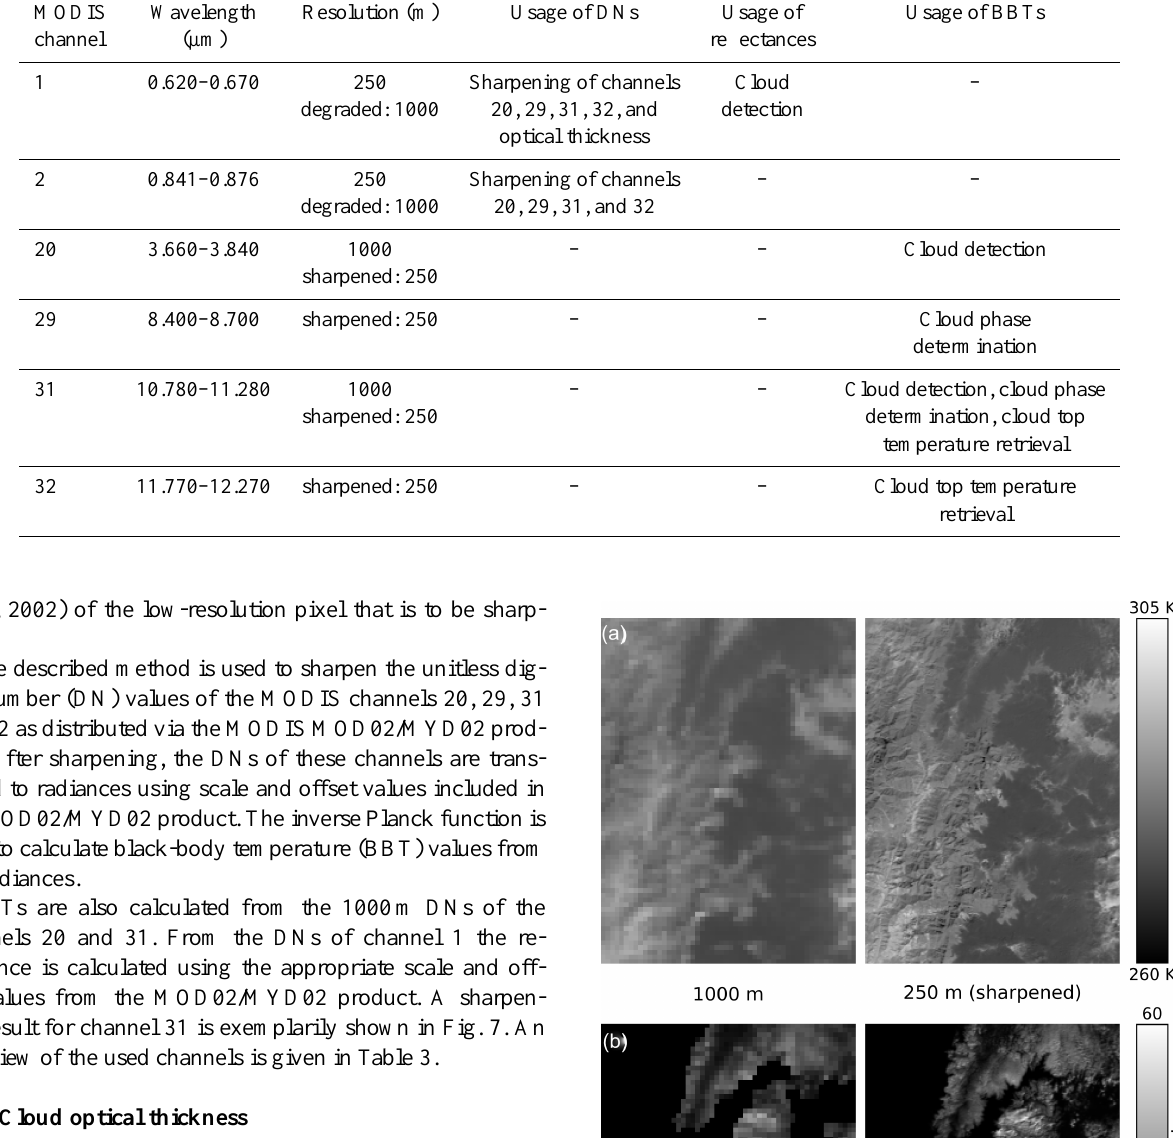
Table 3. MODIS channels that are used in the creation of input data for DOGMA. MODIS Usage of DNs